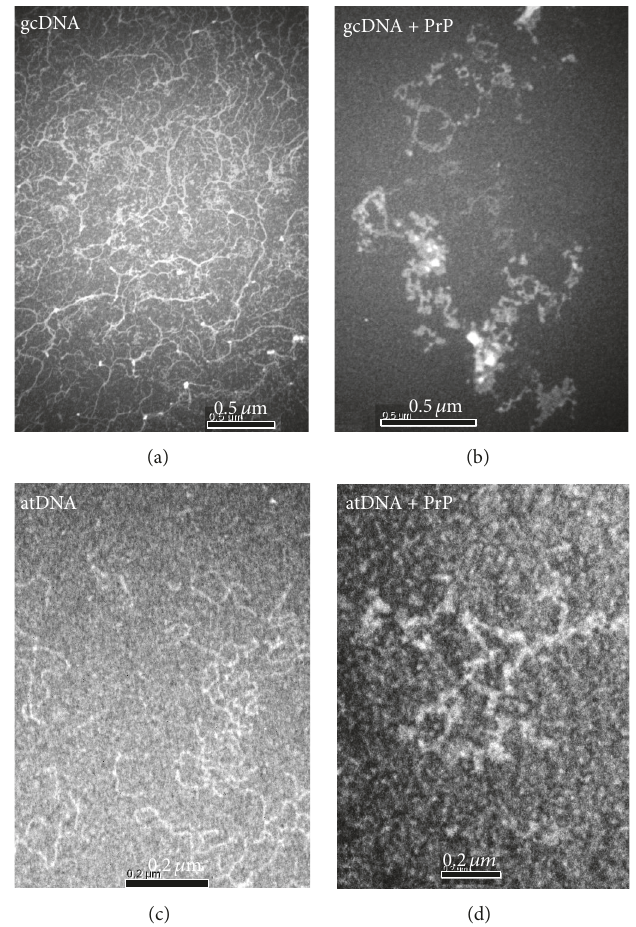
Figure 11: The ultrastructure of DNA-PrP interaction was analysed by scanning electron microscopy (SEM) technology. The electron microscopy generated morphology of gcDNA (5 𝜇 M DNA-phosphate) alone and after addition of 𝛼 -PrP (12 𝜇 M; 1 minute of incubation) to it ((a) and (b)). The scale bar represents 500 nm. Morphology of atDNA (5 𝜇 M DNA-phosphate) alone and morphology of with 𝛼 -PrP (12 𝜇 M) after 1 minute of incubation ((c) and (d)). The scale bar represents 200 nm. A clear condensed gcDNA structure was observed in the presence of 𝛼 -PrP